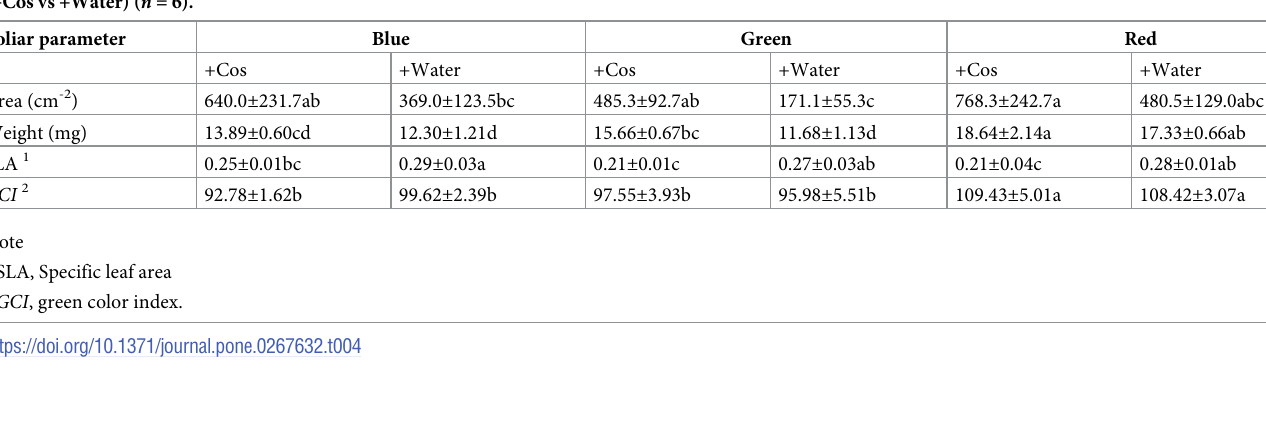
Spectral condition and Cos spray had a combined effect on LA ( F = 12.32; Sig . = 0.0001), 2,30 single leaf weight ( F = 3.79; Sig . = 0.0340), SLA ( F = 11.89; Sig . < 0.0001), and GCI ( F 2,30 2,30 = 3.75; Sig . = 0.0352). Seedlings in the spectrum of red light with Cos spraying had larger 2,30 LA than those sprayed by water in spectra of blue and green lights (Table 4). Single leaf weight was higher in seedlings exposed to the spectrum of red light with Cos spray than in those exposed to spectra of blue and green lights. In contrast, SLA was found to be lower in seedlings in the spectra of red and green lights with Cos spray. GCI was found to be higher in seedlings in the spectrum of red light compared to seedlings subjected to other treatments.